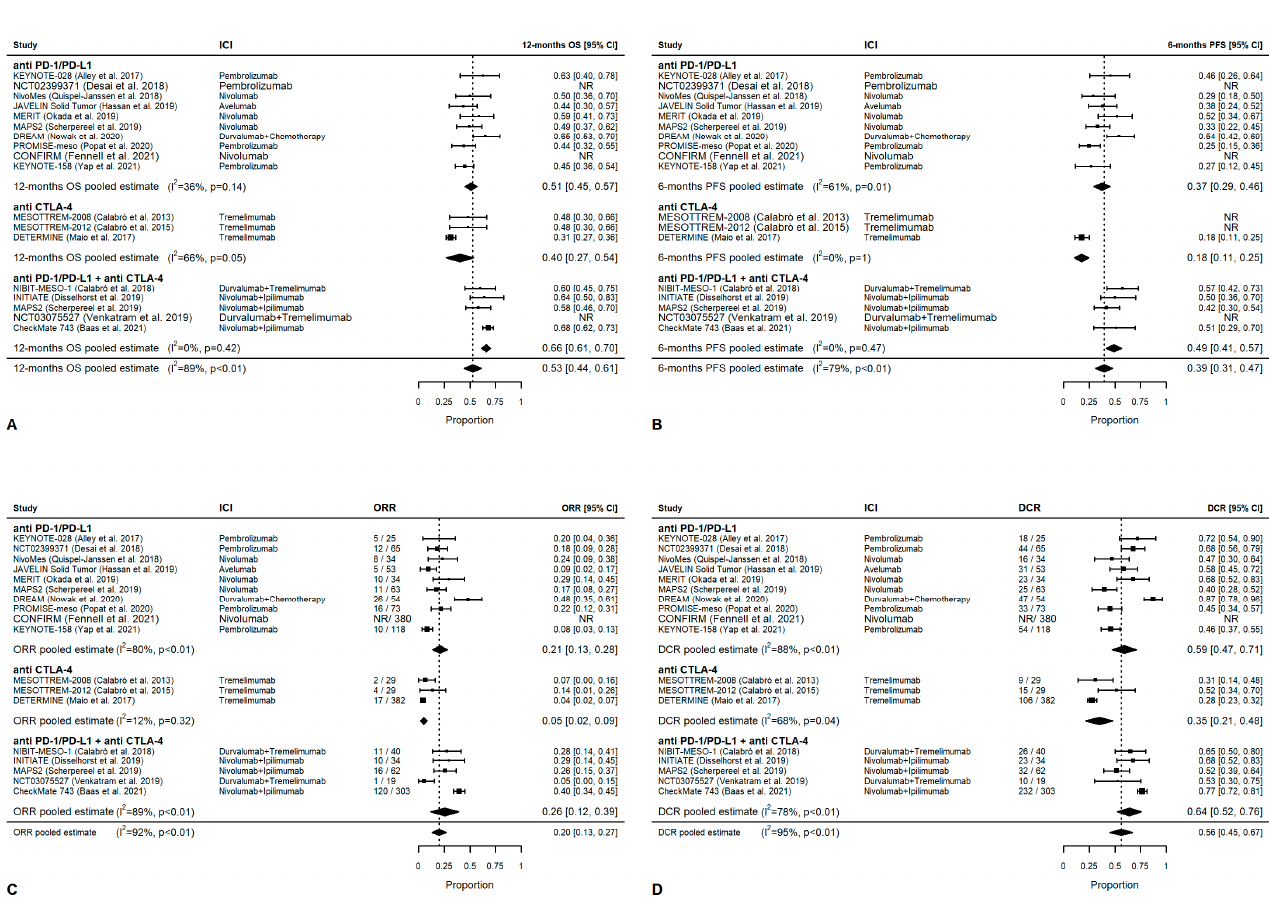
Figure 2. Efficacy endpoint by agent. ( A ) OS probability at 12 months, ( B ) PFS probability at 6 months, ( C ) ORR, and ( D )